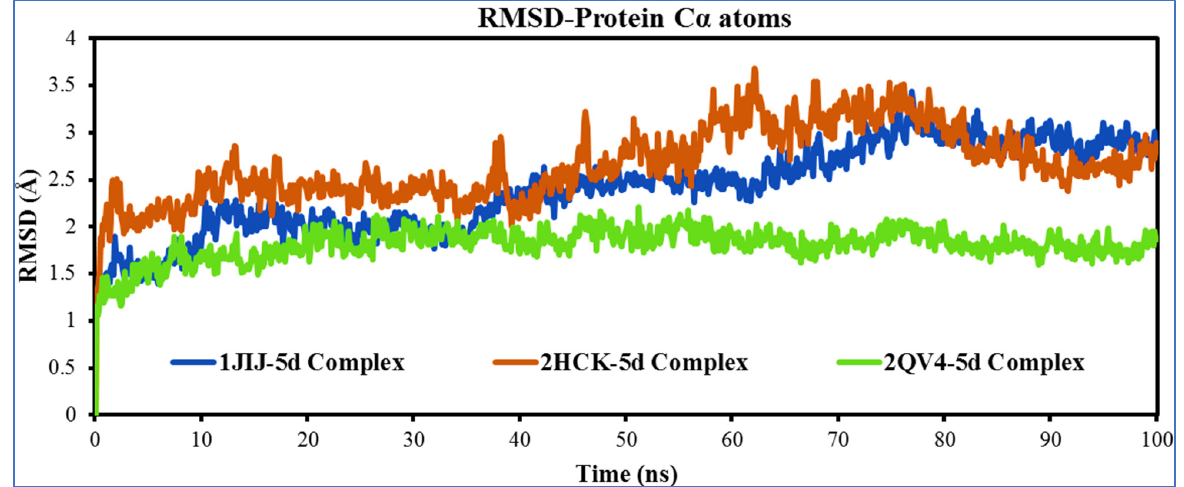
Figure 5. Time dependent RMSD plots of 1JIJ- 5d complex (Blue), 2HCK- 5d complex (red), and 2QV4- 5d complex (green) obtained from 100 ns MD simulation Trajectories.